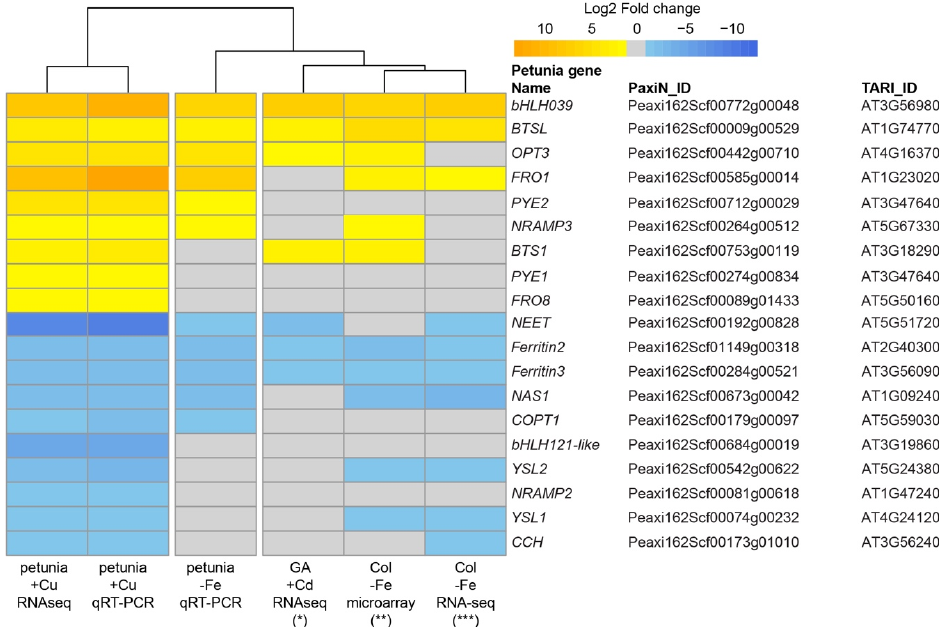
Figure 8. Heatmap showing the expression profile of genes related to Fe homeostasis in petunia petals under Cu excess, petunia petals under Fe depletion, N. caerulescens shoots under Cd excess and Arabidopsis shoots under Fe deficiency. The value of petunia is log2 fold change of qRT-PCR. The log2 fold change of genes with fold change < 2 or FDR ( p -value for Col) >0.05, all been marked as 0. * data was download from Halimaa et al. [42]. ** data was download from Schuler et al. [44]. *** data was download from Kastoori Ramamurthy et al. [21].